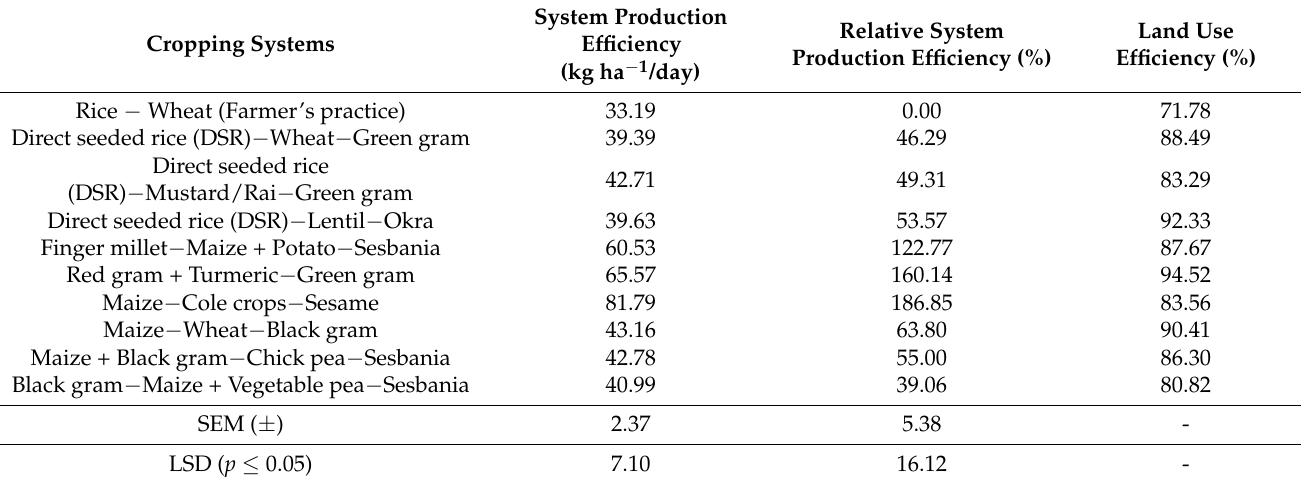
Table 5. System production efficiency, relative system production efficiency and land use efficiency as affected by the diversified cropping